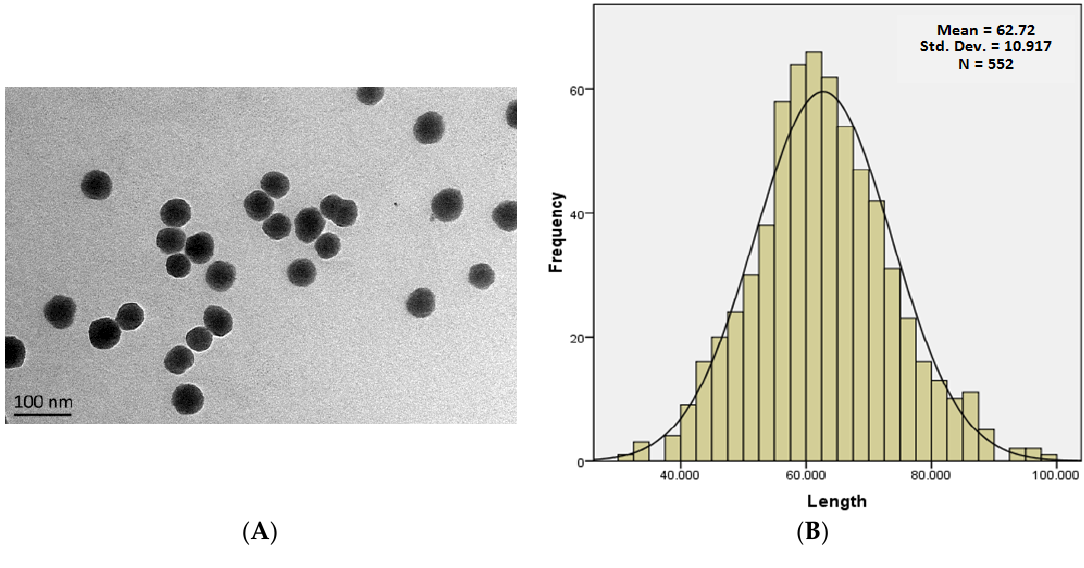
Figure 1. Characterization of SNPs. ( A ) TEM images show spherical SNPs with good monodispersity in distilled water; ( B ) Size distribution of SNPs showing a normal distribution curve, mean = 62.720 ± 10.917. Table 1. Hydrodynamic size and Zeta potential of silica nanoparticles in dispersion media.